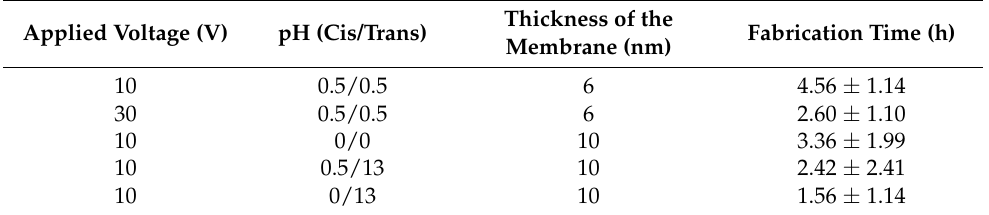
Table 1. The relationship between the film thickness, applied voltage, pH, and fabrication time. Applied Voltage